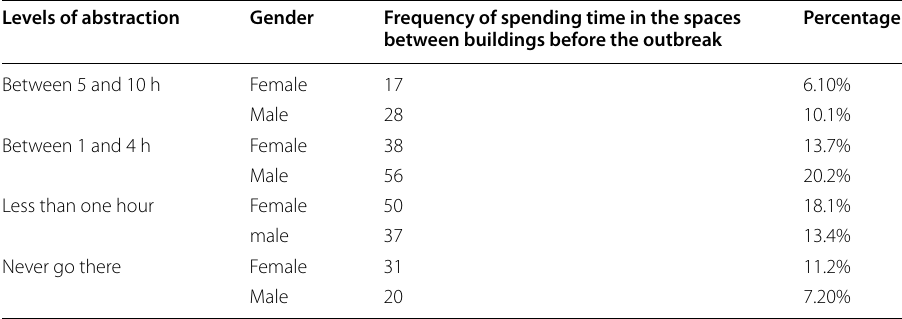
Table 2 The frequency of going to the spaces between buildings before the outbreak of gender differences